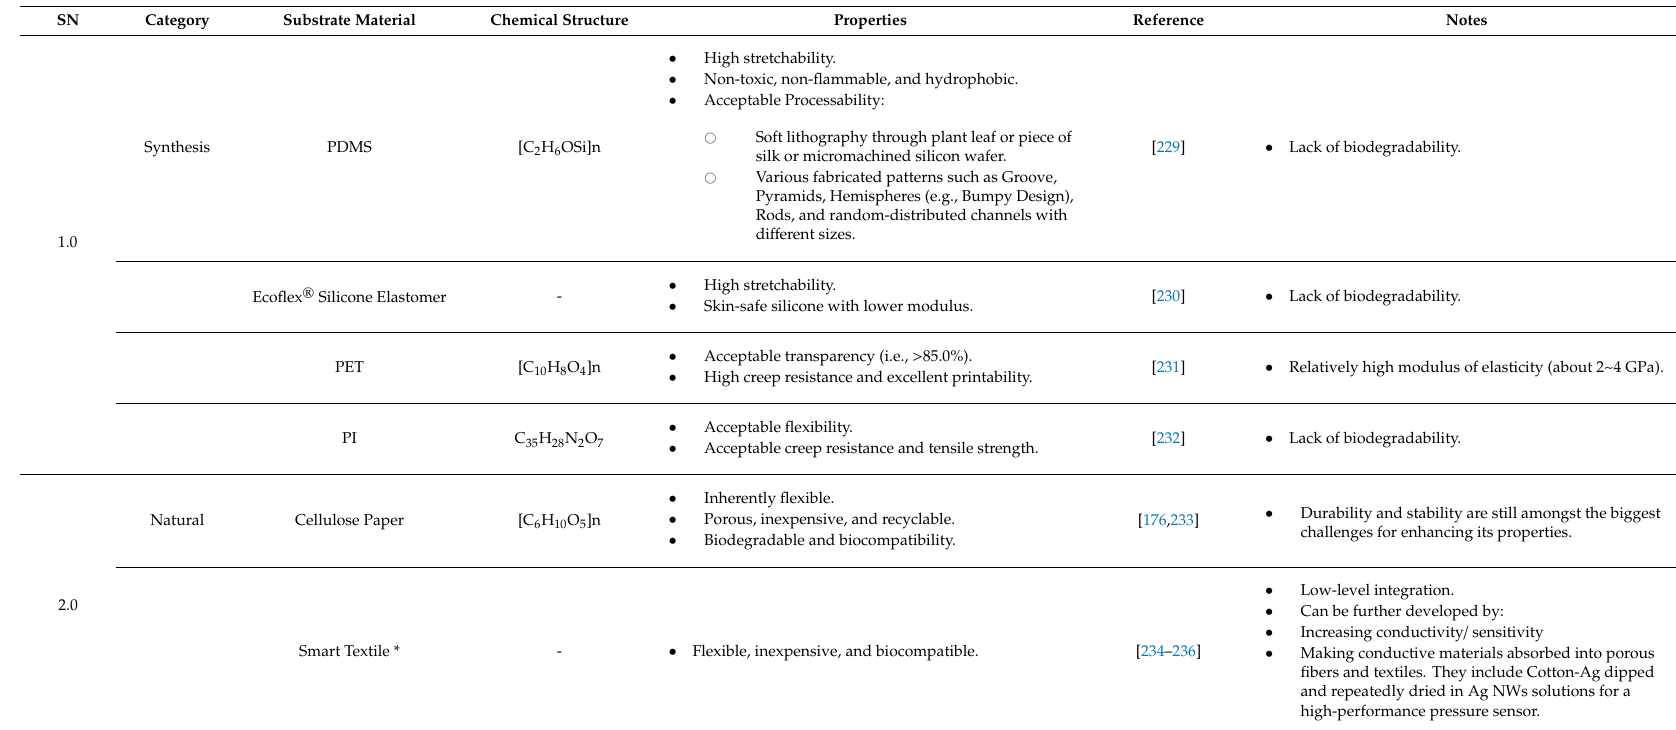
Table 3. List of biomaterials used as a substrate in wearable